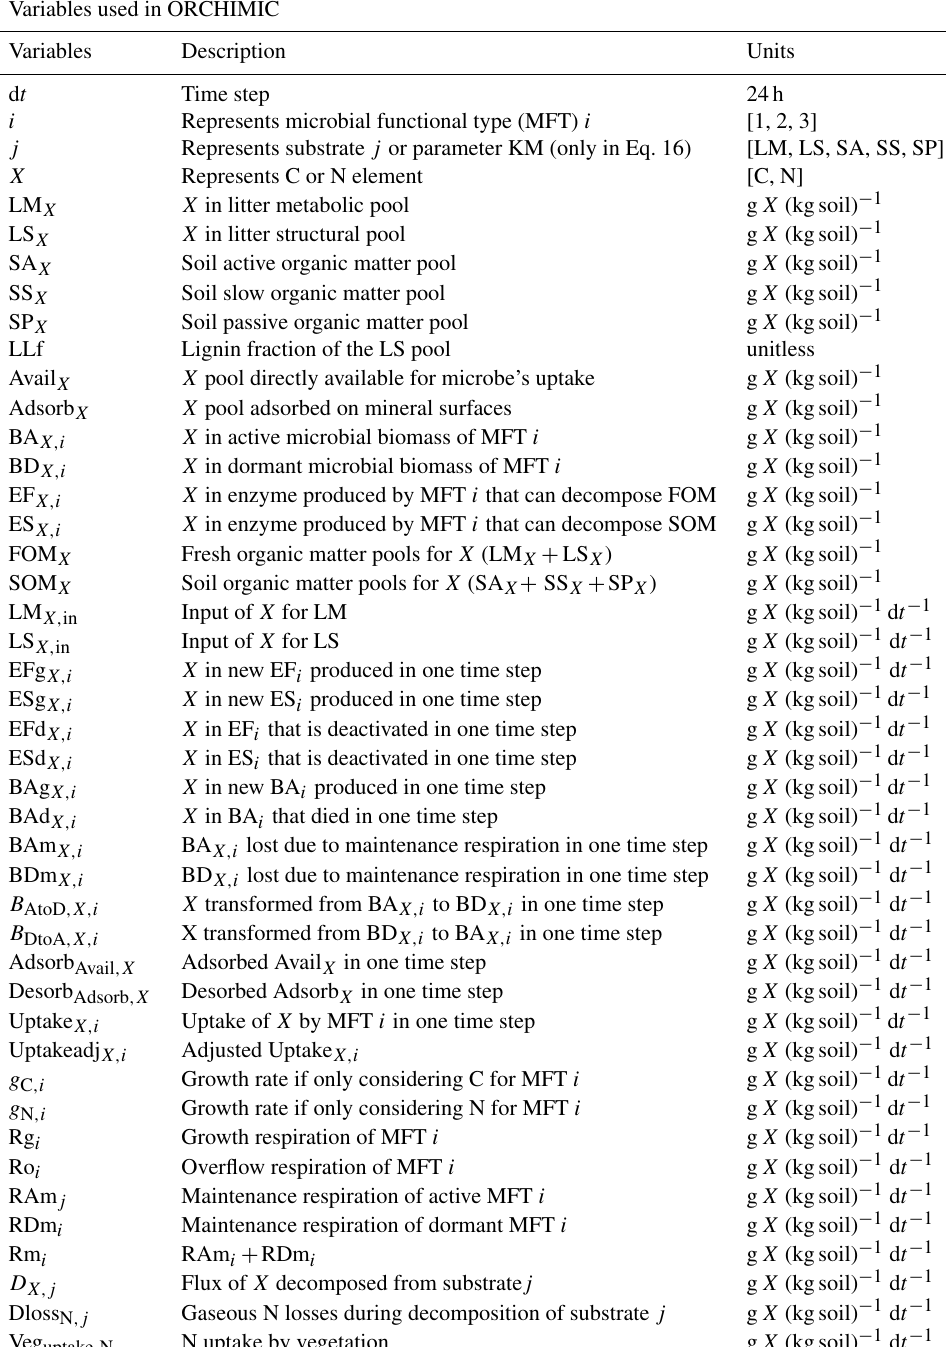
Table 1. List of variables and parameters used in this study. Variables used in ORCHIMIC Variables Description Units Time step Represents microbial functional type (MFT)